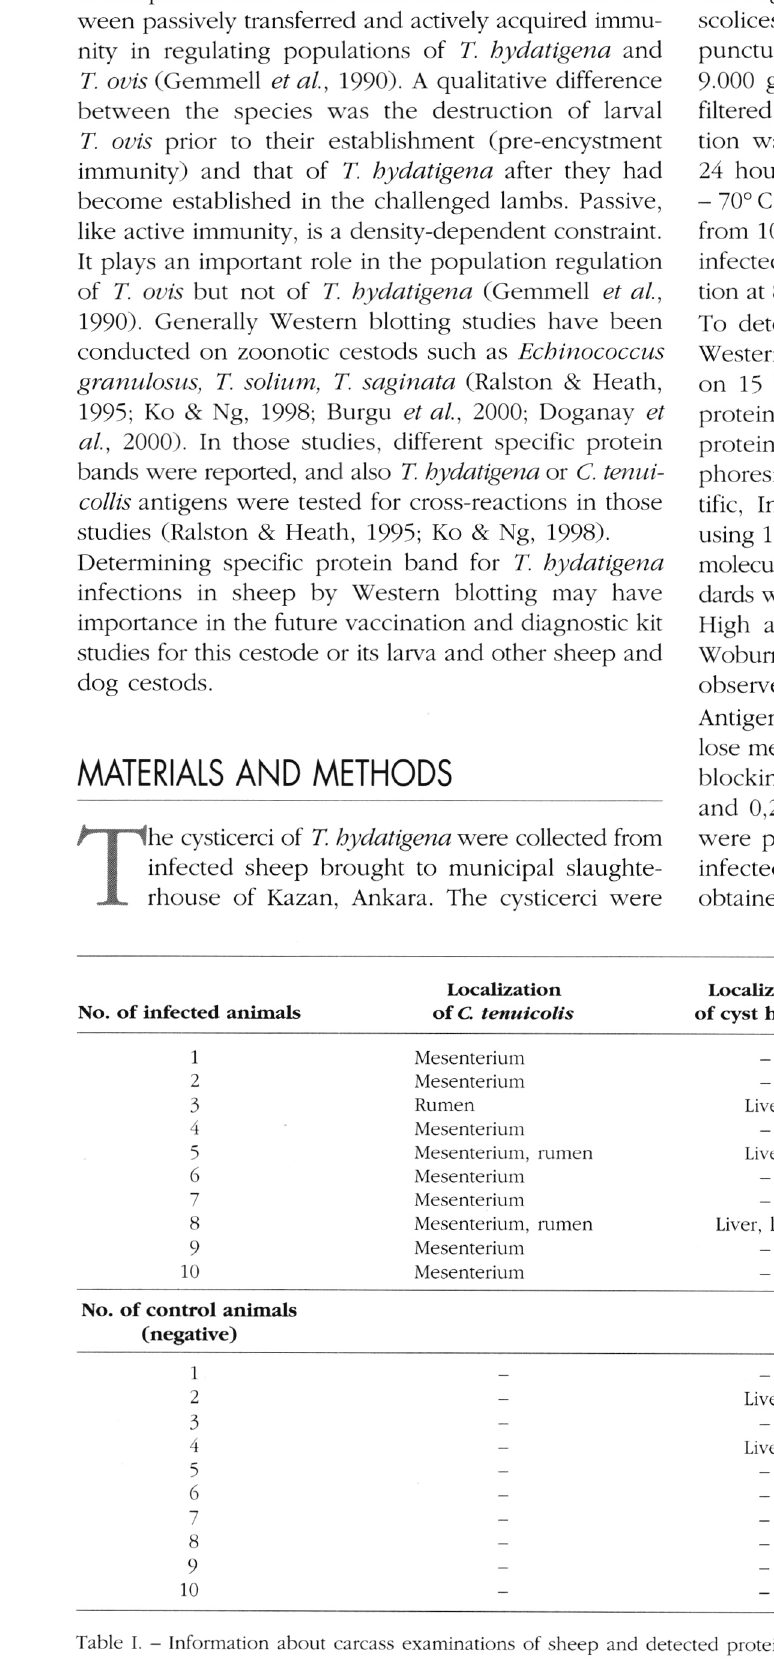
Table I. - Information about carcass examinations of sheep and detected protein